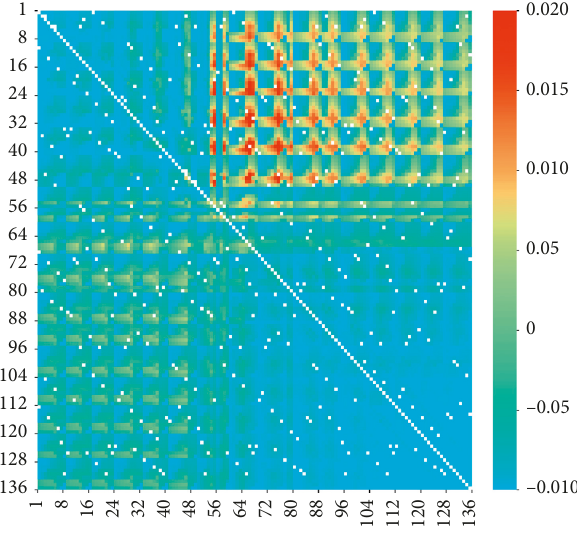
Figure 8: The change rate of OD matrix. Table 3: Statistics on the change rates of OD demand and link flow.